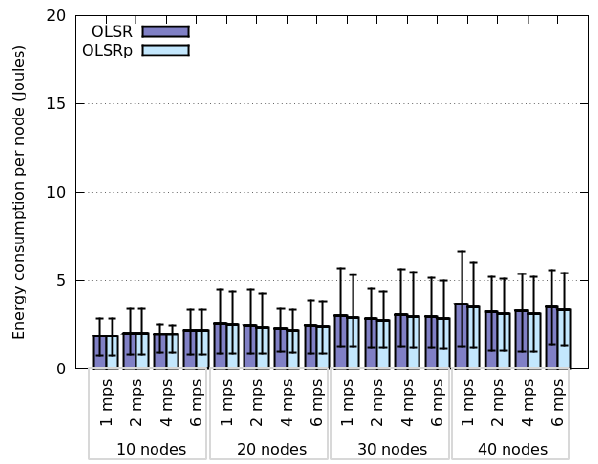
Figure 14. Energy consumption when nodes follow a RPGM model.